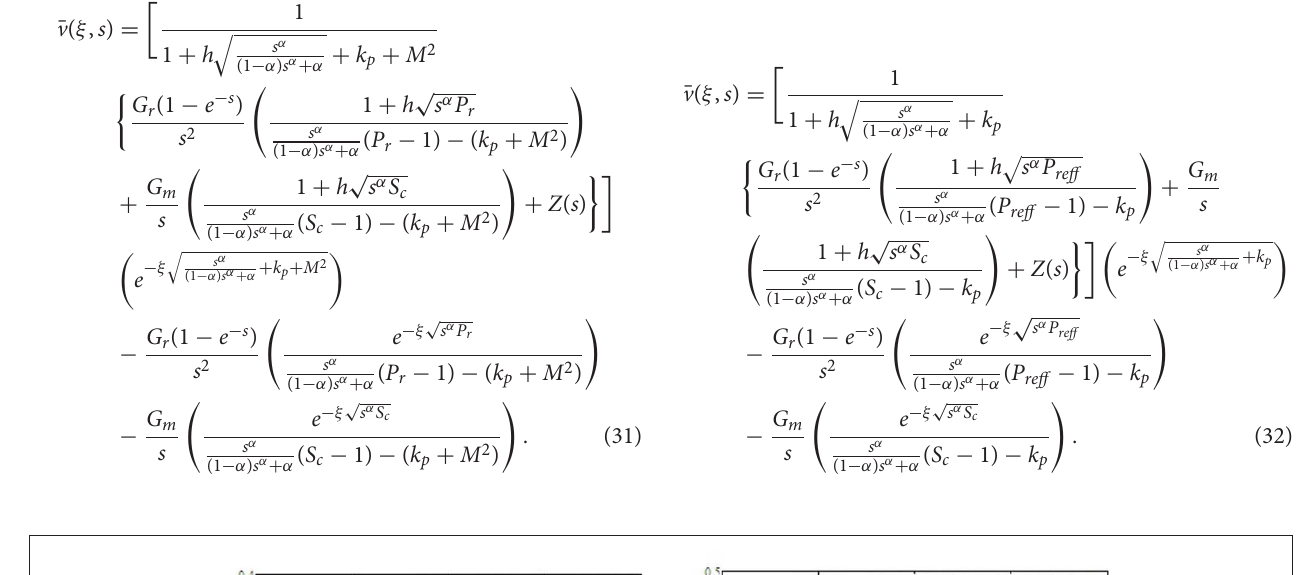
0.5, G r 2, P reff 0.1, k p 1.5, M 0.9, and S c = = = = =